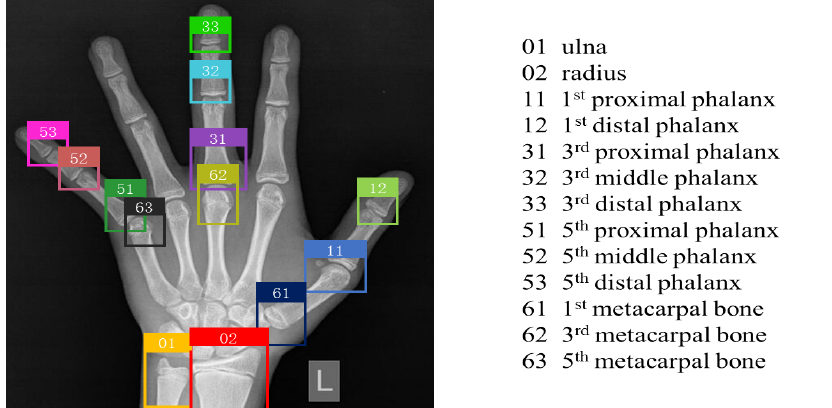
Figure 5. Training set image marked by the doctor. The rectangular box is the callout area, and the differently colored rectangular boxes represent different bone categories.